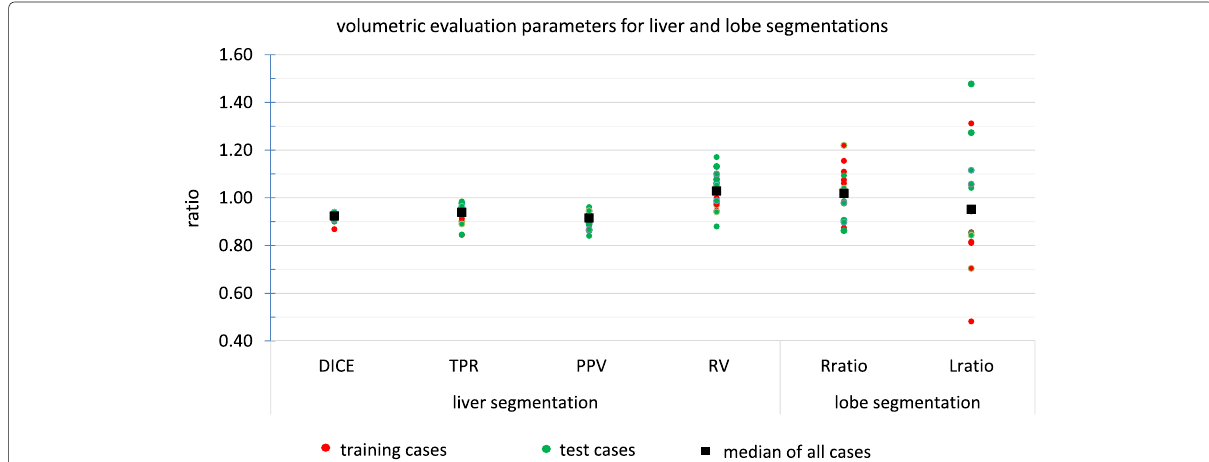
Fig. 10 Volumetric evaluation of liver and lobe segmentation for training and test cases. Dice coefficient, true positive ratio, positive protective value, and relative volume for liver manual and automatic segmentation and ratio between right/left lobe volumes for two different lobe segmentation procedures (anatomical lobe segmentation on CT and LPT segmentation on